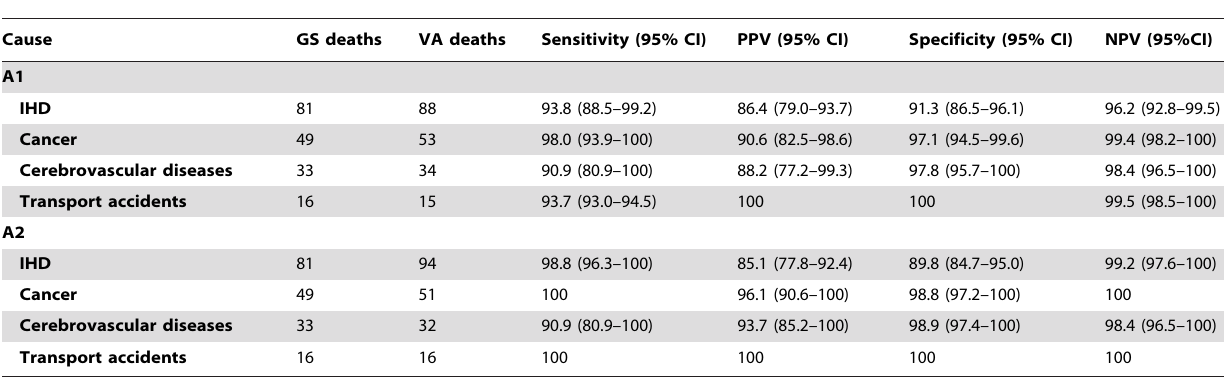
Table 5. Validation characteristics of VA interviews in diagnosing cause of death for 4 selected causes in 219